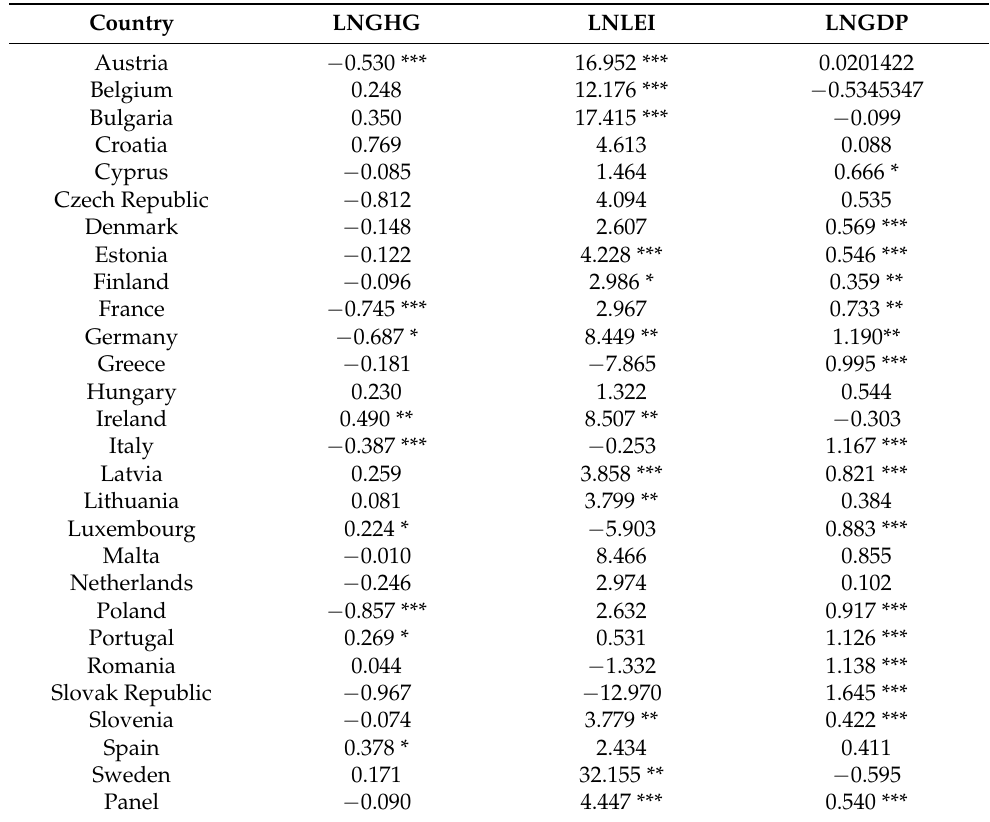
Table 6. Long-run cointegrating